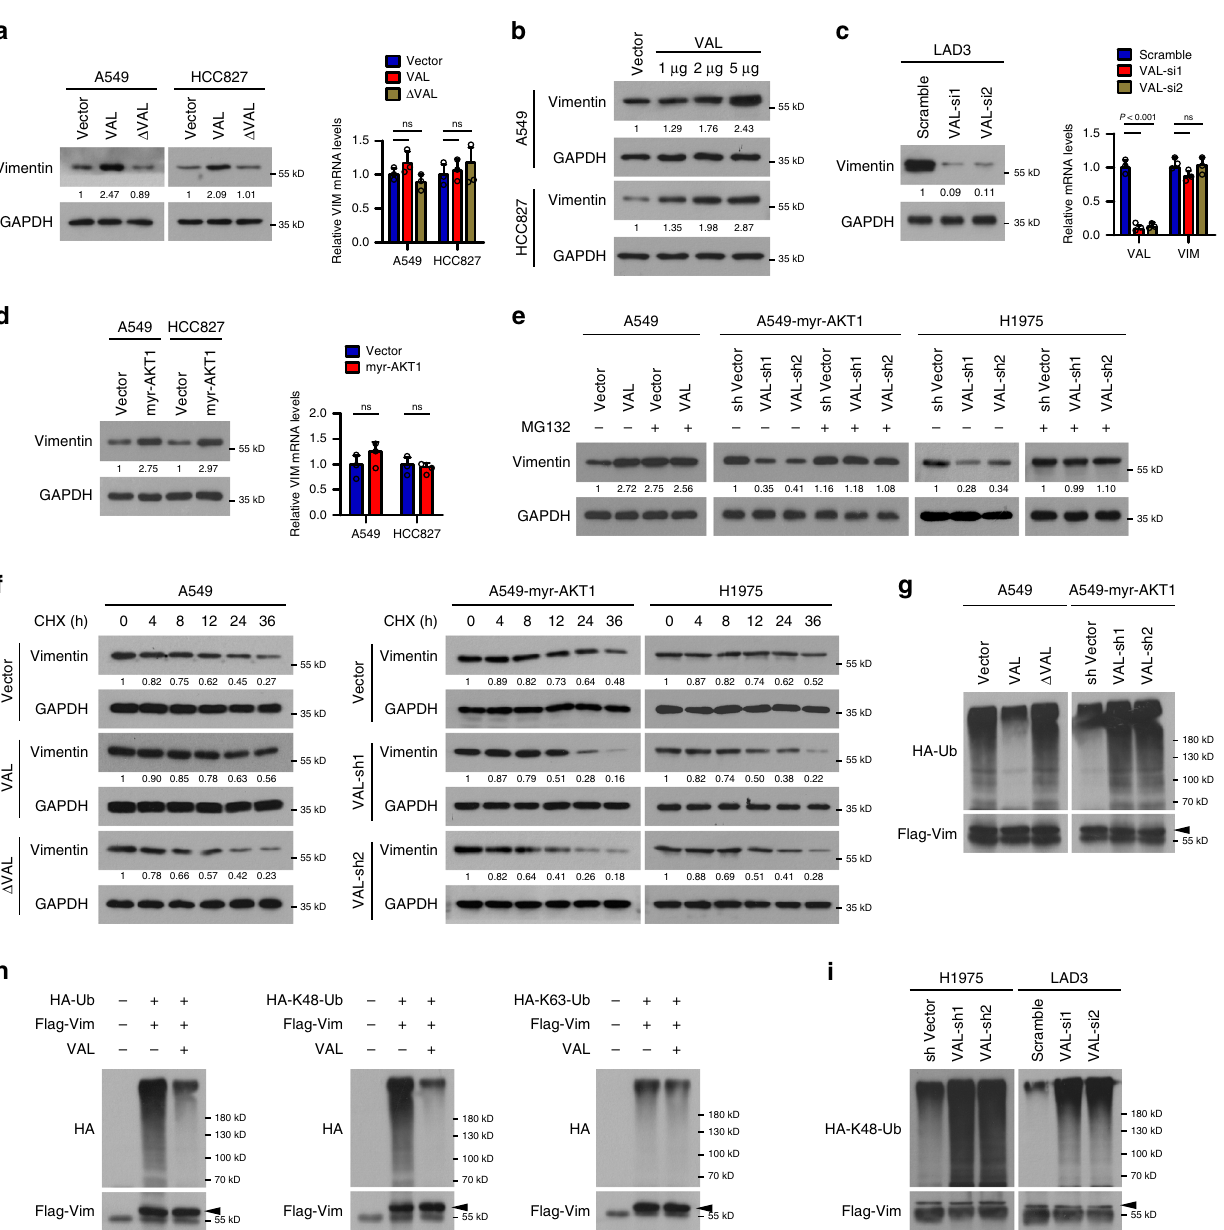
Fig. 5 VAL inhibits Ubiquitin-mediated Vimentin degradation. a The effect of overexpressing Vimentin-interactive VAL or Δ VAL unable to bind Vimentin on protein and mRNA levels of Vimentin. b WB analysis of Vimentin expression in LAD cells transfected with various dosages of VAL expressing- or control-vector plasmids. c The effect of silencing VAL on the protein and mRNA levels of Vimentin in primary LAD cells LAD3. d The effect of overexpressing myr-AKT1 on protein and mRNA levels of Vimentin. e WB analysis of Vimentin expression in the indicated cells treated with or without MG132. f The effect of overexpressing VAL or Δ VAL, or silencing VAL on the half-life of Vimentin was evaluated in the indicated cells treated with cyclohexamide (CHX) and collected at the indicated time points. g – i The effect of overexpressing Vimentin-interactive VAL or Δ VAL, or silencing VAL on the levels of K48-, or K63-linked polyubiquitination of Vimentin was evaluated by immunoprecipitation of FLAG-tagged Vimentin in control-vector- or myr- AKT1-overexpressing A549 cells or VAL-silenced H1975 and LAD3 cells. Representative images derived from one of three independent experiments are presented. Relative protein levels were quanti fi ed by scanning densitometry and calculated as Band Intensity of Protein of Interest/Band Intensity of GAPDH ( a – f ). Error bars represent the means ± SD derived from three independent experiments. Statistical analyses were performed by two-tailed unpaired Student ’ s t test ( a , c , d ). n.s., not signi fi cant. Source data are provided as a Source Data fi